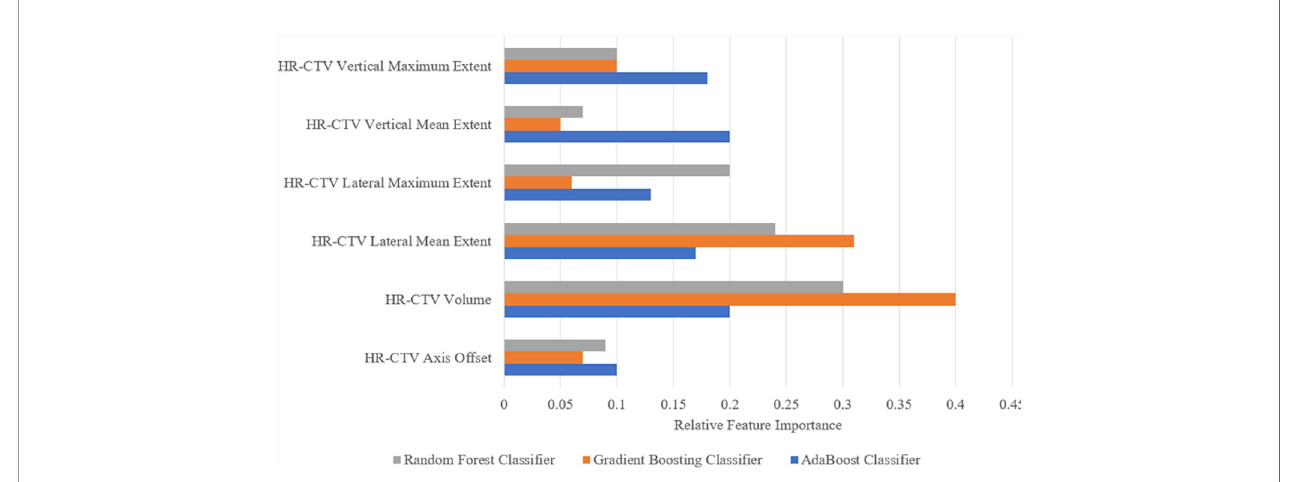
FIGURE 5 | Feature importance for the six geometric features used in the three individual models selected for the fi nal voting model. The more an attribute is used to make key decisions, the higher its relative importance. Importance is calculated by the amount that each attribute split point improves the performance measure (accuracy) of the algorithm.